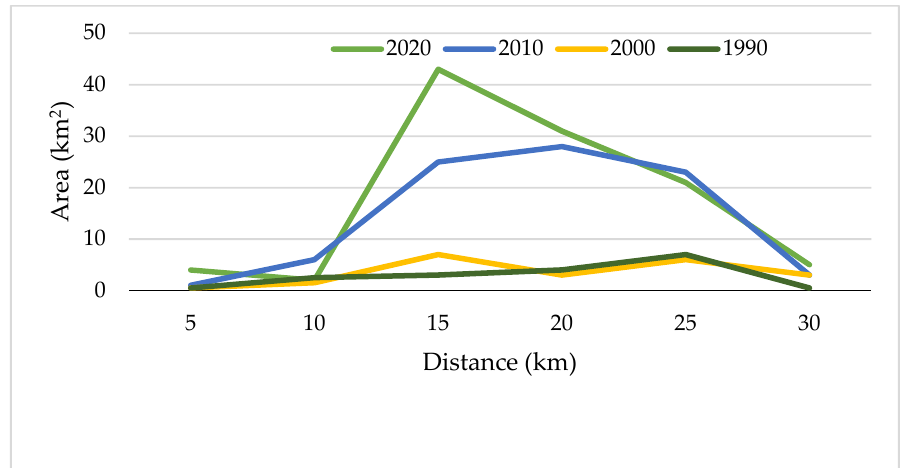
Figure 11. Distribution of built-up area by distance.